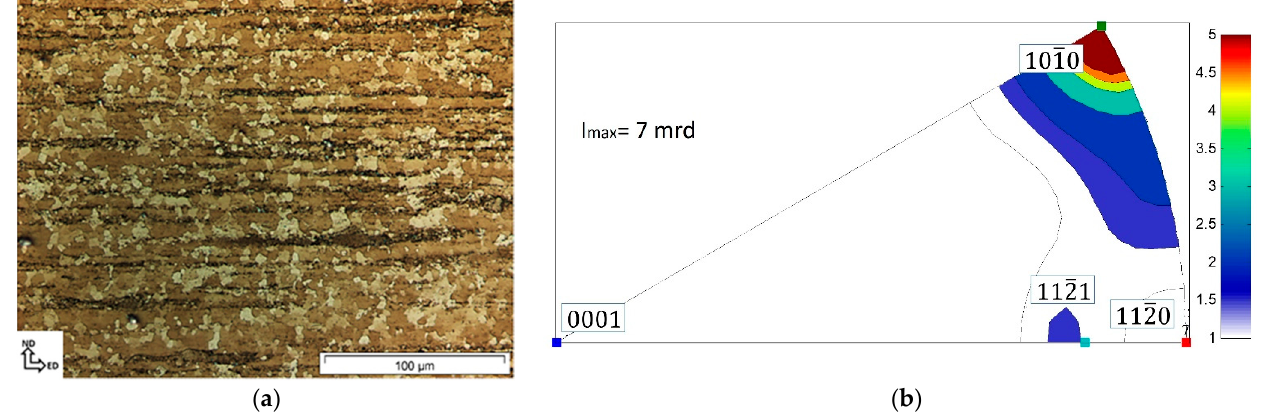
Figure 3. Microstructure of alloy ZK60 as received ( a ) and inverse pole figure (0001) ( b ).